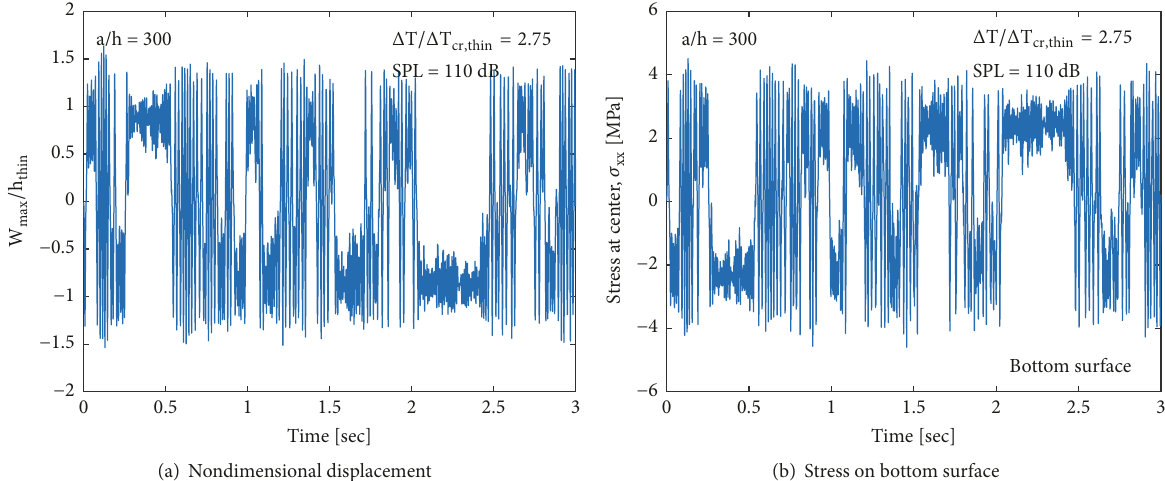
Figure 7: Snap-through responses (a/h =